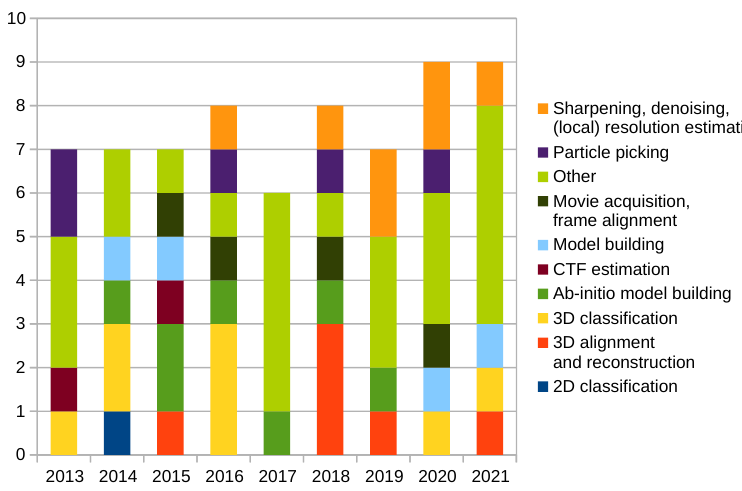
Figure 4. Xmipp related publications by